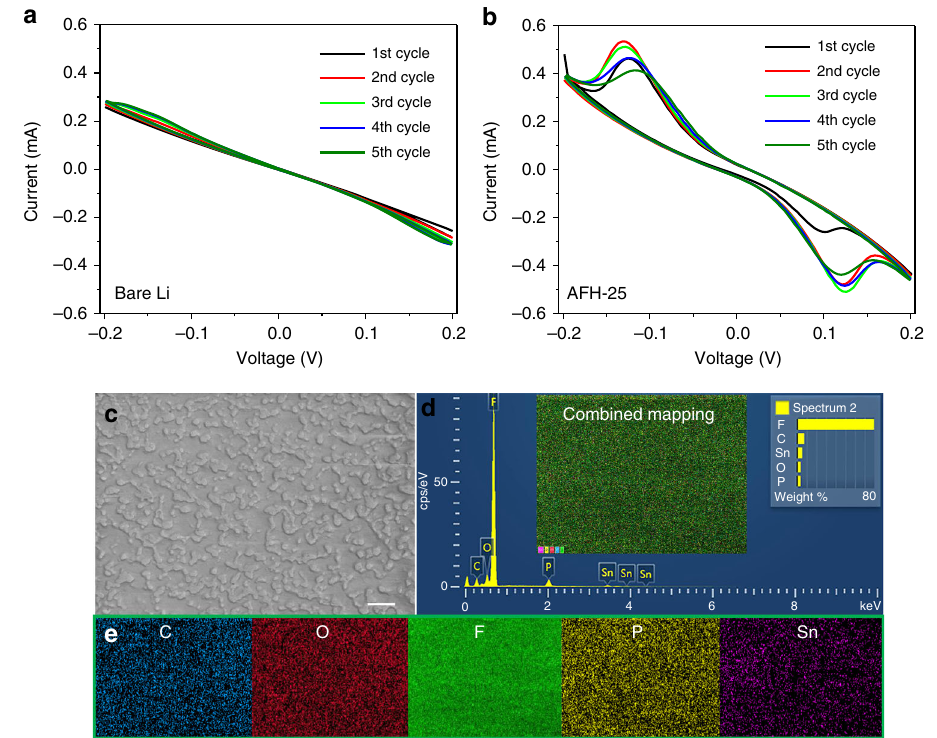
Fig. 4 Electrochemical performance and high-resolution SEM imaging. a , b CV measurements of bare Li and AFH-25 symmetrical cells, respectively. c The high-resolution SEM image of AFH-25. The scale bar is 2 μ m. d The corresponding EDS of the aforementioned area. e The corresponding elemental mapping of the aforementioned